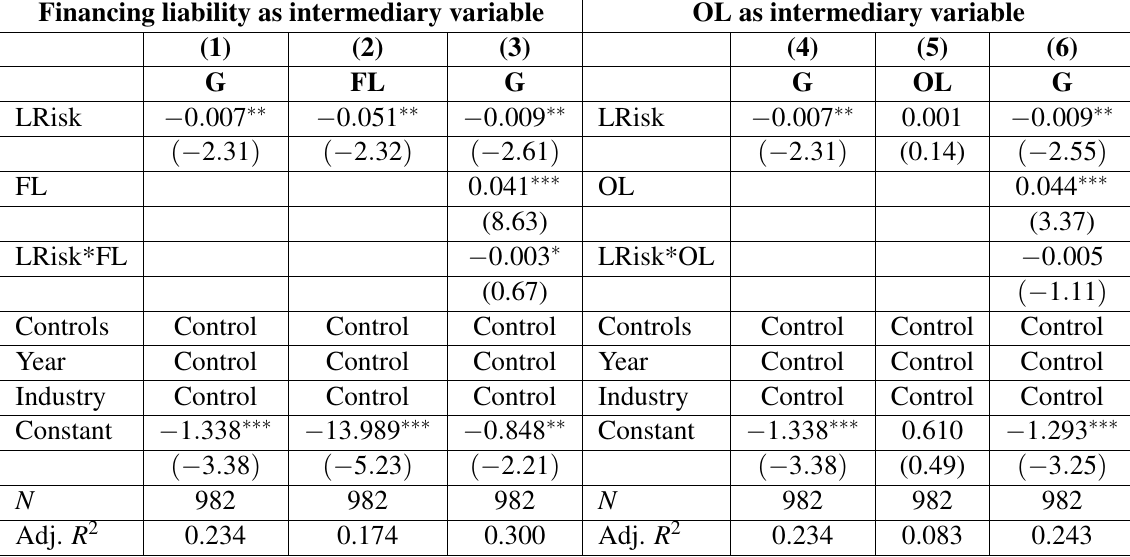
Table 6 A test of intermediary role of debt